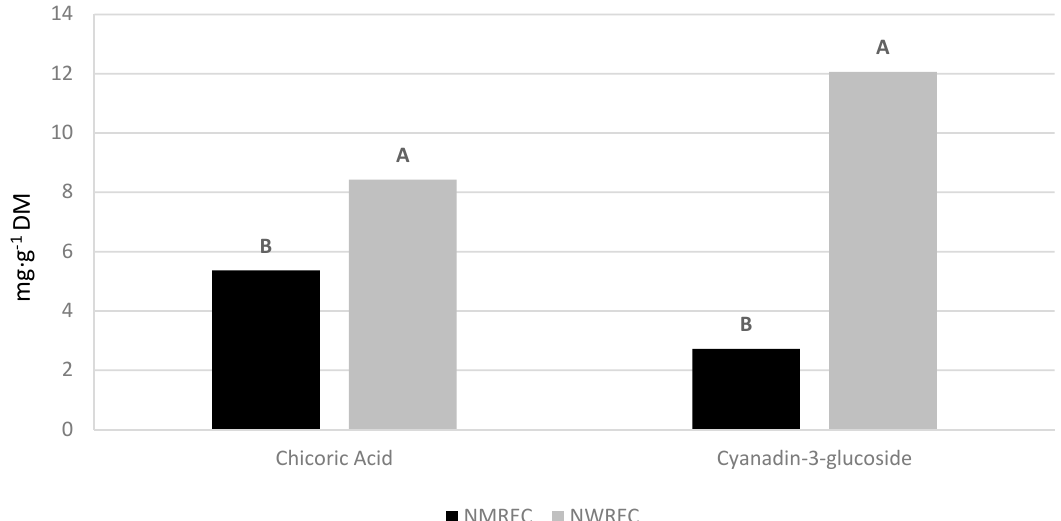
Figure 4. Concentrations of chicoric acid and cyanidin-3-glucoside concentrations in leaf tissue of ‘Salvius’ and ‘Thurinus’, red and green romaine lettuce cultivars, respectively, when growing locations are compared (i.e., the North Mississippi Research and Extension Center (NMREC) in the Mississippi State University, Verona, MS, USA and the Northwest Washington Research and Extension Center (NWREC) in the Washington State University, Mount Vernon, WA, USA). Values followed by the same letter are not significantly different at p ≤ 0.05 according to the Tukey’s Honest Significant Difference test.